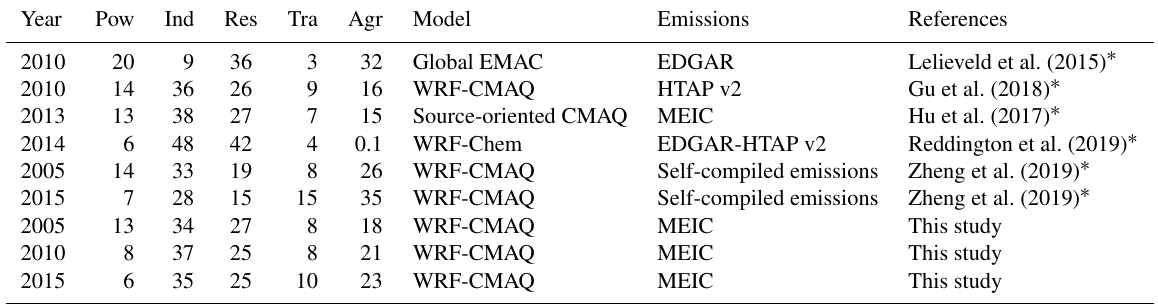
Table 3. Comparison of anthropogenic source contributions to PM 2 . 5 -related premature mortality with previous studies (%). The source sectors include Power (Pow), Industry (Ind), Residential (Res), Transportation (Tra), and Agriculture